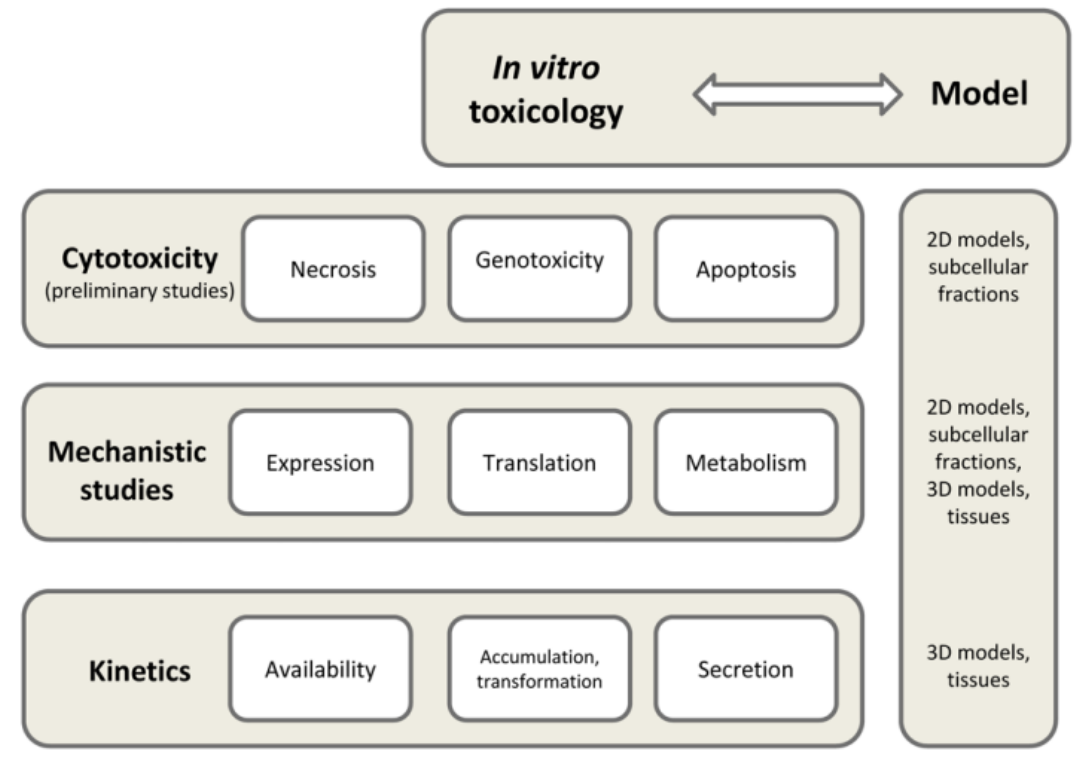
Figure 2. Functional cell models in in vitro